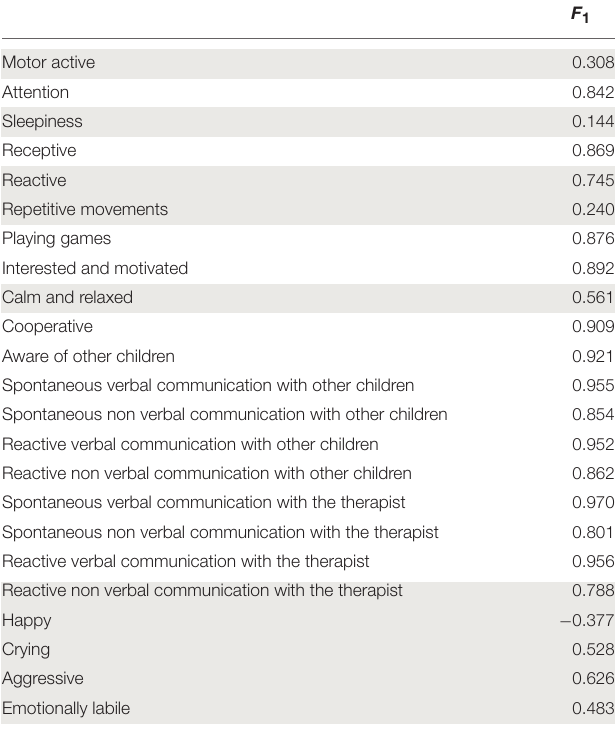
TABLE 3 | Factor scores F 1 for each item.